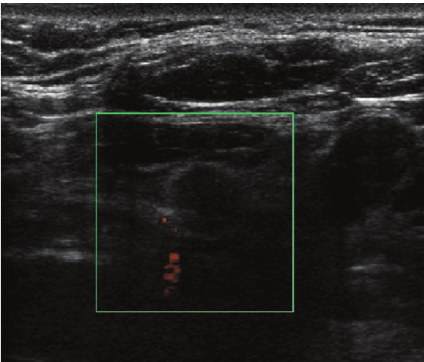
Figure 1: Thyroid ultrasound. Hypoechoic nodule in the inferior pole of the left thyroid lobe.